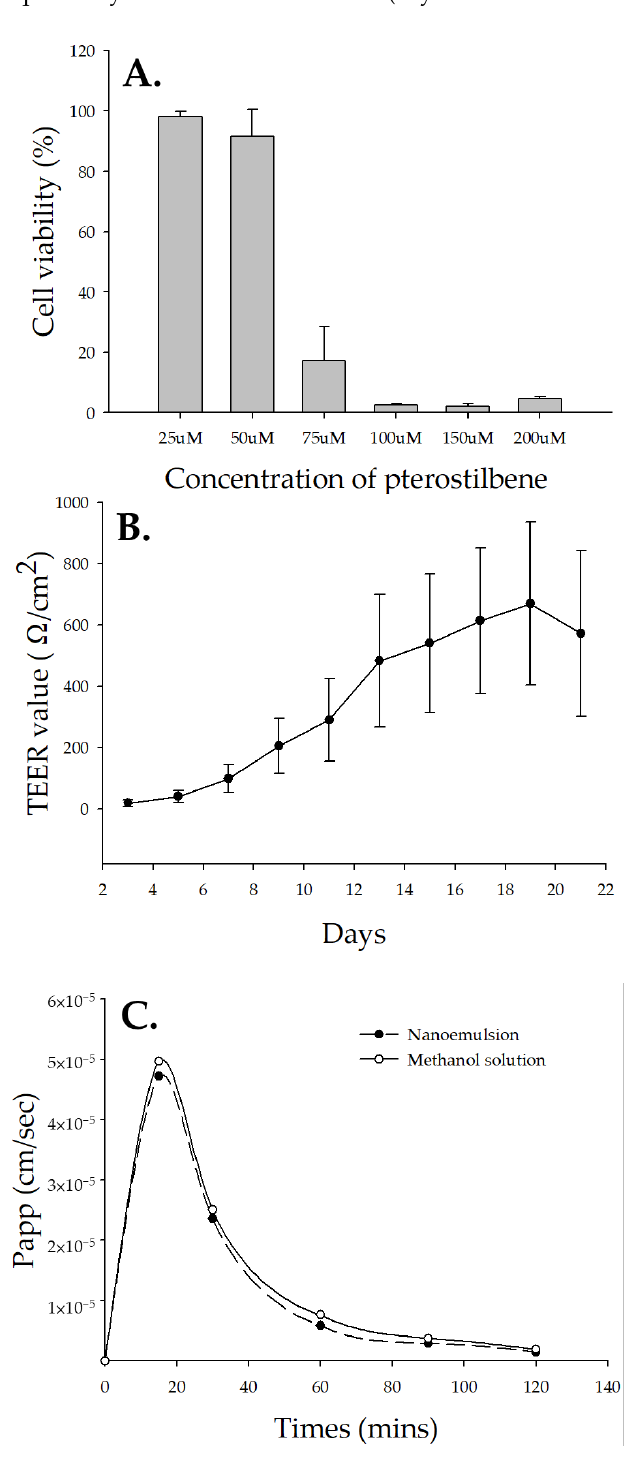
Figure 5. ( A ) Cell viability after being treated with 25–200 µM of pterostilbene. ( B ) The trans- epithelial electrical resistance (TEER) value of caco-2 monolayer over 22 days of cultivation period and ( C ) transport kinetics of pterostilbene through the caco-2 monolayer. To properly carry out the transport study using caco-2 monolayer assay, it is im- portant to ensure the membrane integrity over the cultivation period, during which cells slowly differentiate themselves into a structure similar to the intestine epithelium. Thus, a well-differentiated monolayer structure should have a tight junction formed between